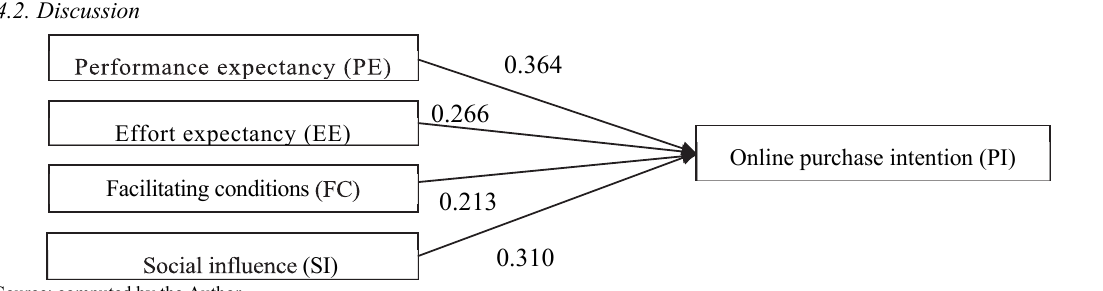
Fig. 2. Results of testing the